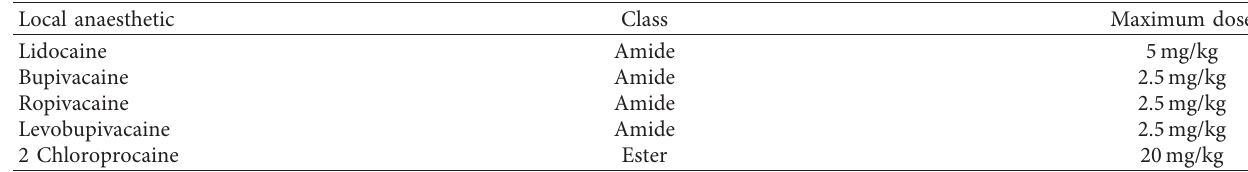
Adapted from NYSORA: Regional Anesthesia in Pediatric Patients: General